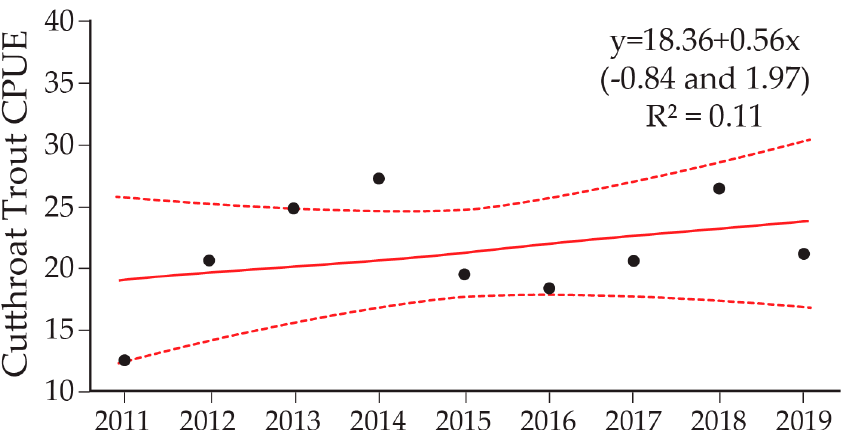
Figure 13. Catch-per-unit-effort (CPUE) of cutthroat trout during annual long-term gillnetting assessment monitoring on Yellowstone Lake, 2011–2019. The red line represents a simple linear regression model with 95% confidence intervals (dashed lines). Numbers within parentheses are the upper and lower 95% confidence limits of the slope parameter estimate, indicating no temporal change in the CPUE response variable because the interval includes zero.